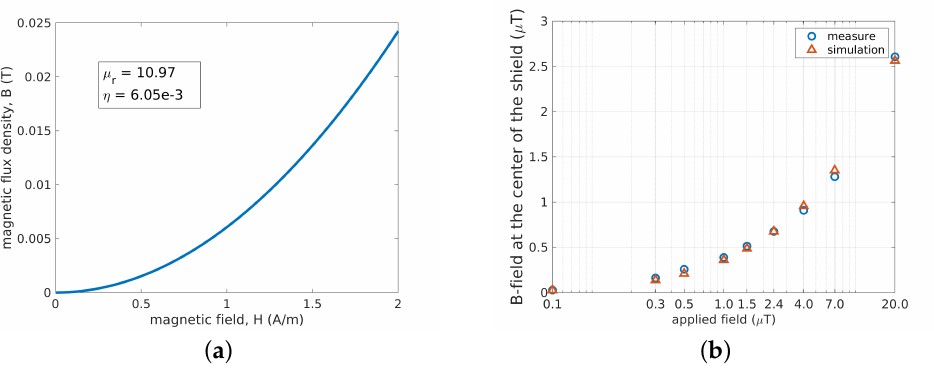
Figure 6. B ( H ) curve in the Rayleigh region obtained with the identification procedure ( a ). Compari- son of measured and simulated magnetic flux density at the center of the shield for different external field values ( b